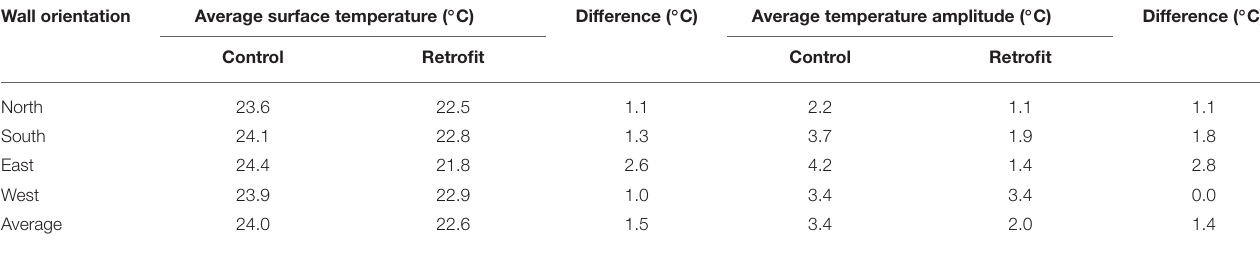
TABLE 3 | Reductions in inside wall surface temperatures and reductions in temperature amplitudes produced by using 20 wt% PCMs. Wall